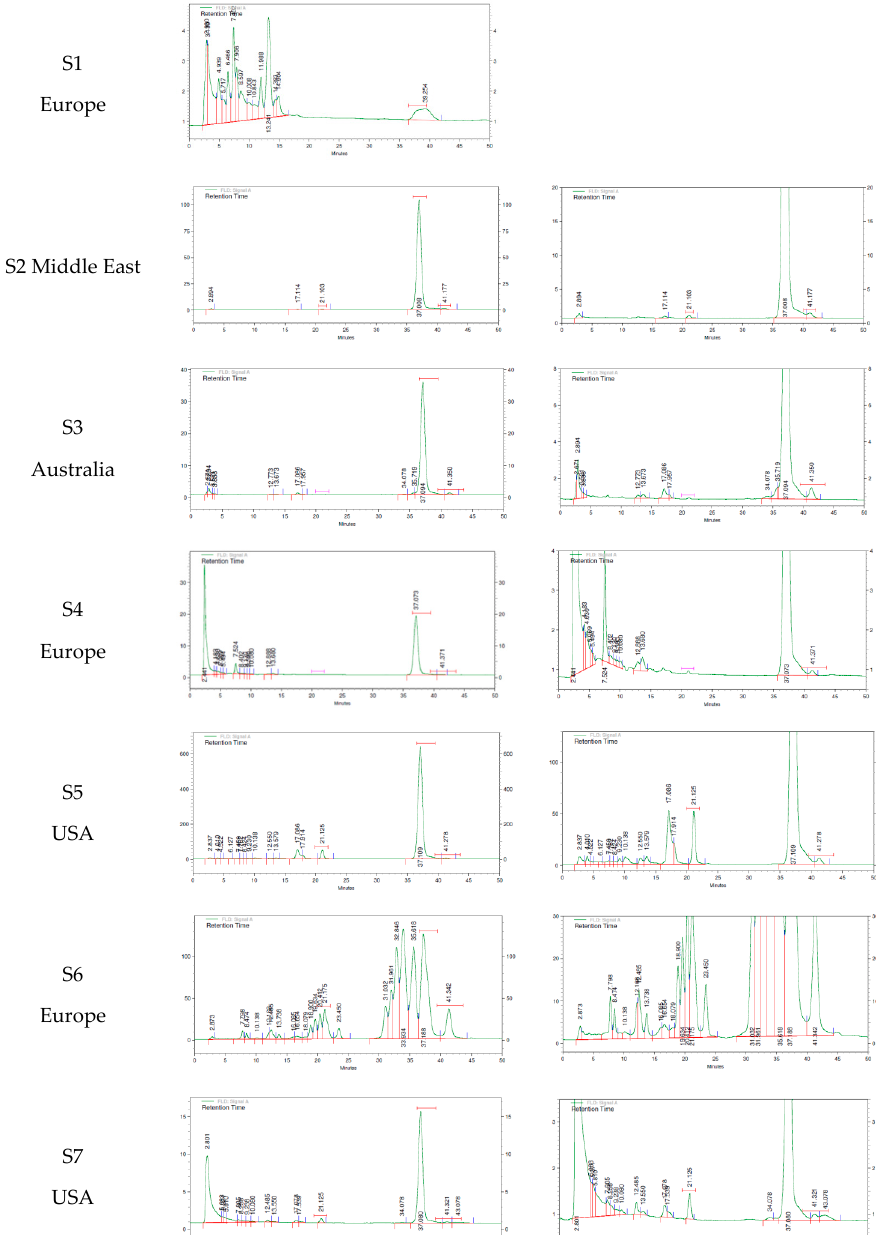
Figure 4. Purity profile of MK7 supplement formulations on the market. Supplier S1–S7 and their nationality is reported (S1–S7). The right panel is a magnification of the left panel, where analysis of minor components is more evident.